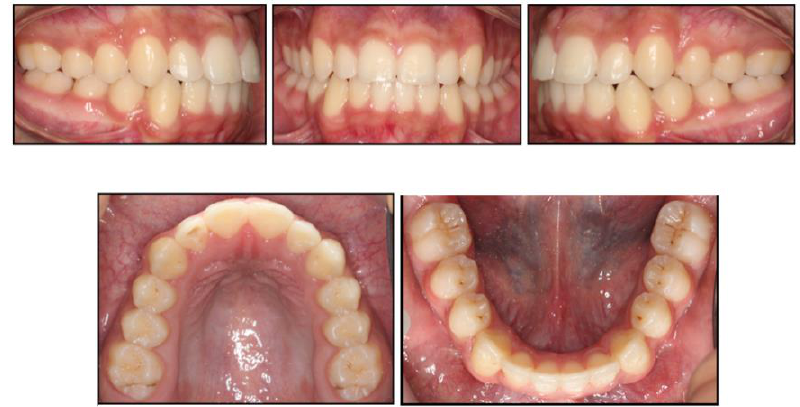
Figure 4. End-of-treatment intraoral photographs. Space closure was fully achieved and orthodontic treatment was completed in 16 months.